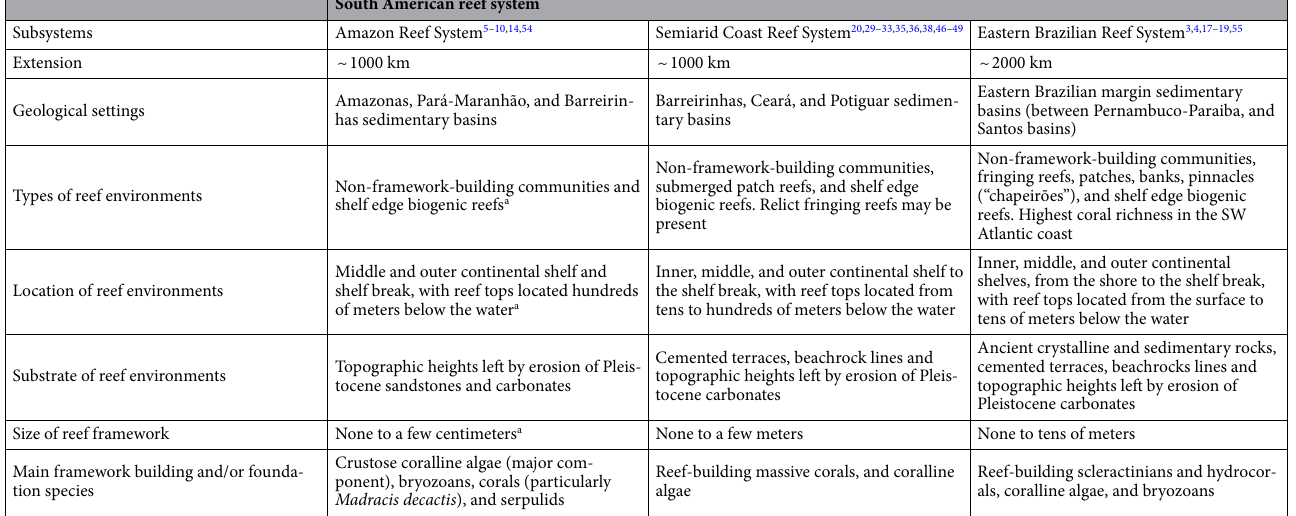
Table 1. Summary description of the main sectors comprising the South American Reef System. a The Manuel Luís Reefs are exceptions. These reefs are located at the border of the Amazon and the Semi-Arid Reef Systems but are generally considered to belong to the former. They are coral-rich formations, which rise steeply to the surface and reach shallow depths 54